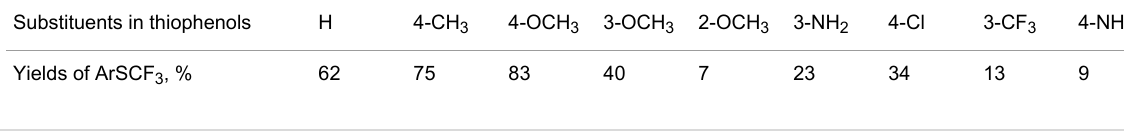
Table 6: Reactions of thiophenoxides with CF 3 Br under UV irradiation and pressure of reaction gas [179].